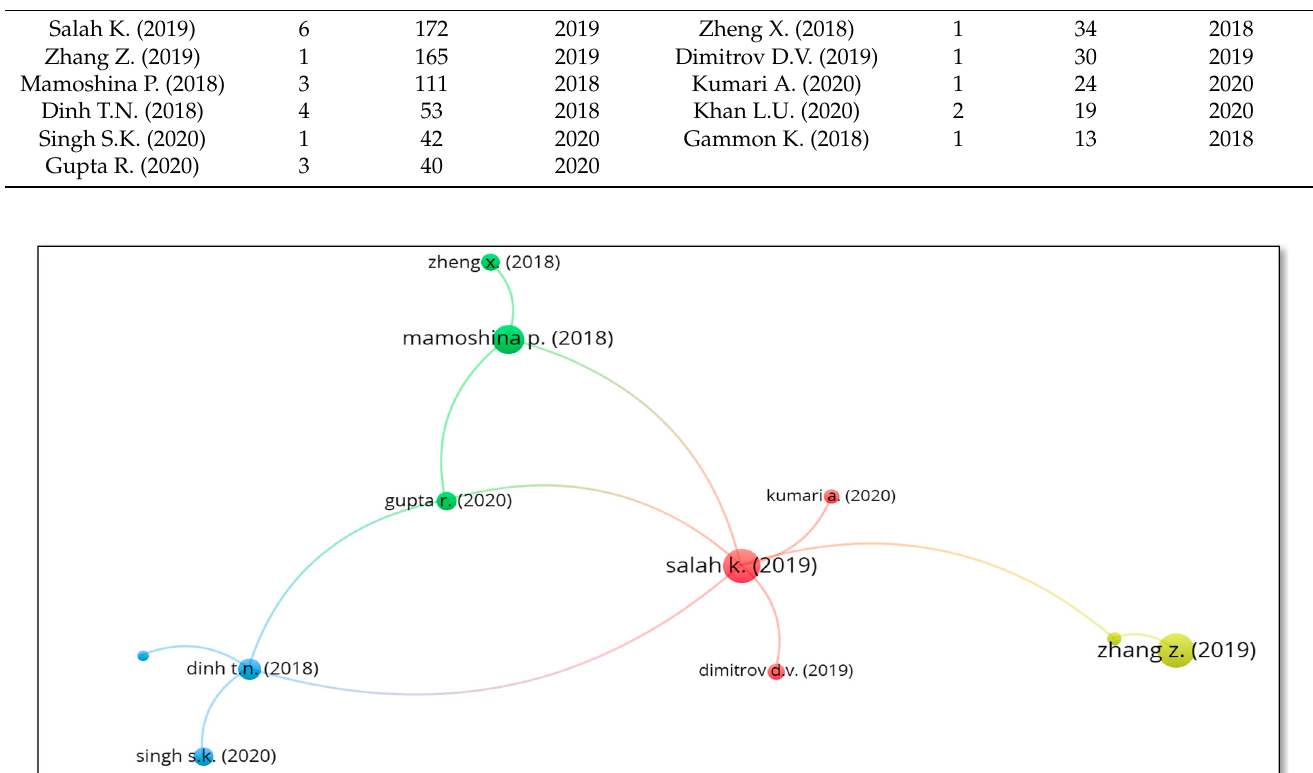
Figure 14. Citation analysis of documents.